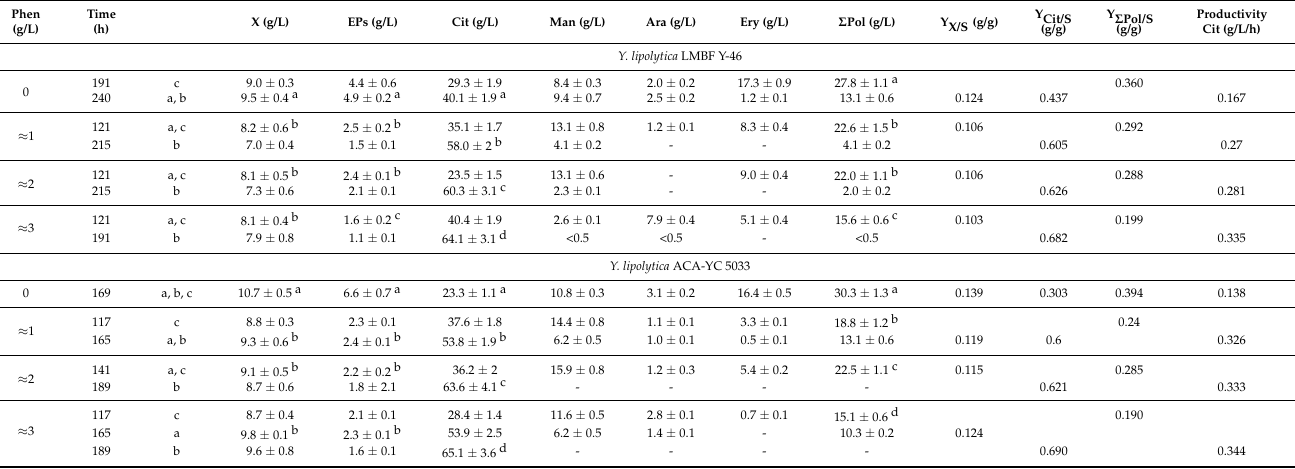
Table 1. Fermentation efficiency of Y. lipolytica LMBF Y-46 and Y. lipolytica ACA-YC 5033 cultivated on blends of olive mill wastewater (OMW) and crude glycerol under nitrogen-limited conditions in shake-flask fermentations. The blends of OMW-glycerol were properly formulated to have different initial phenolics concentrations (Phen) of ca. 1 g/L, 2 g/L and 3 g/L. Different superscript letters within the same column (with respect to the same yeast strain) indicate statistically significant differences ( p <